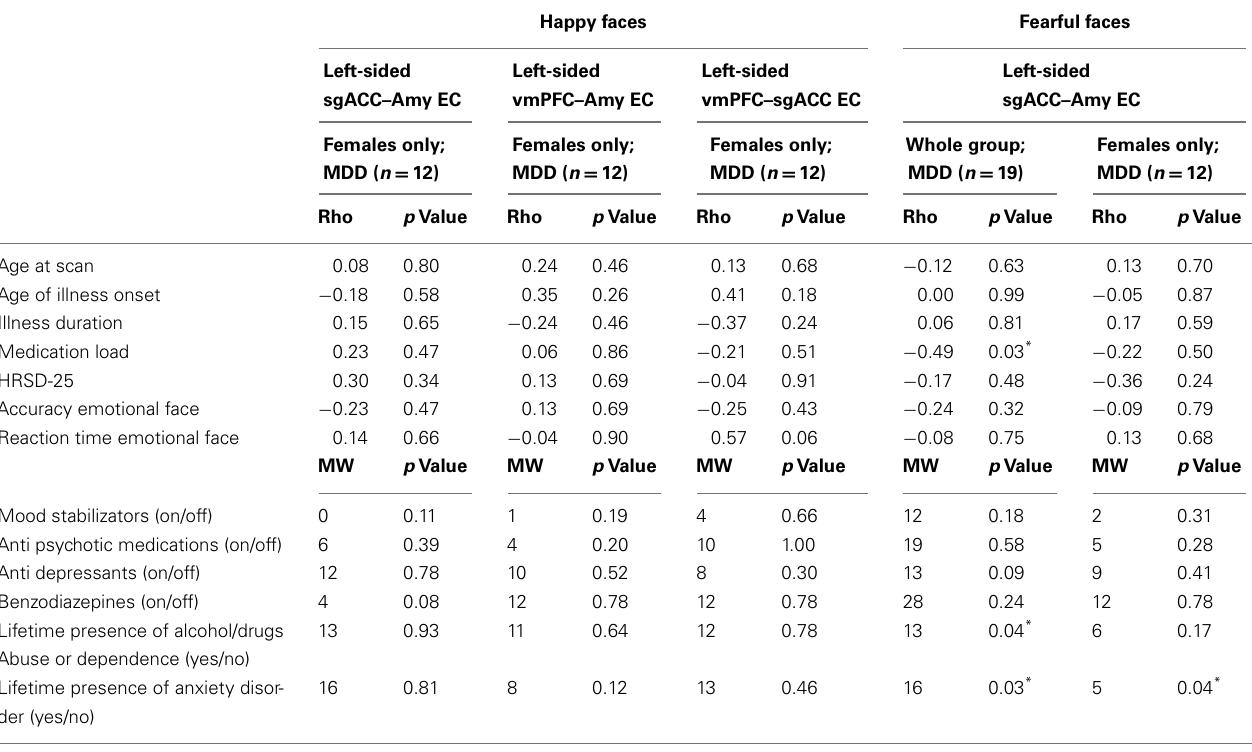
Table 5 | Relation between effective connectivity, clinical, demographic, and experiment performance variables in individuals with MDD.